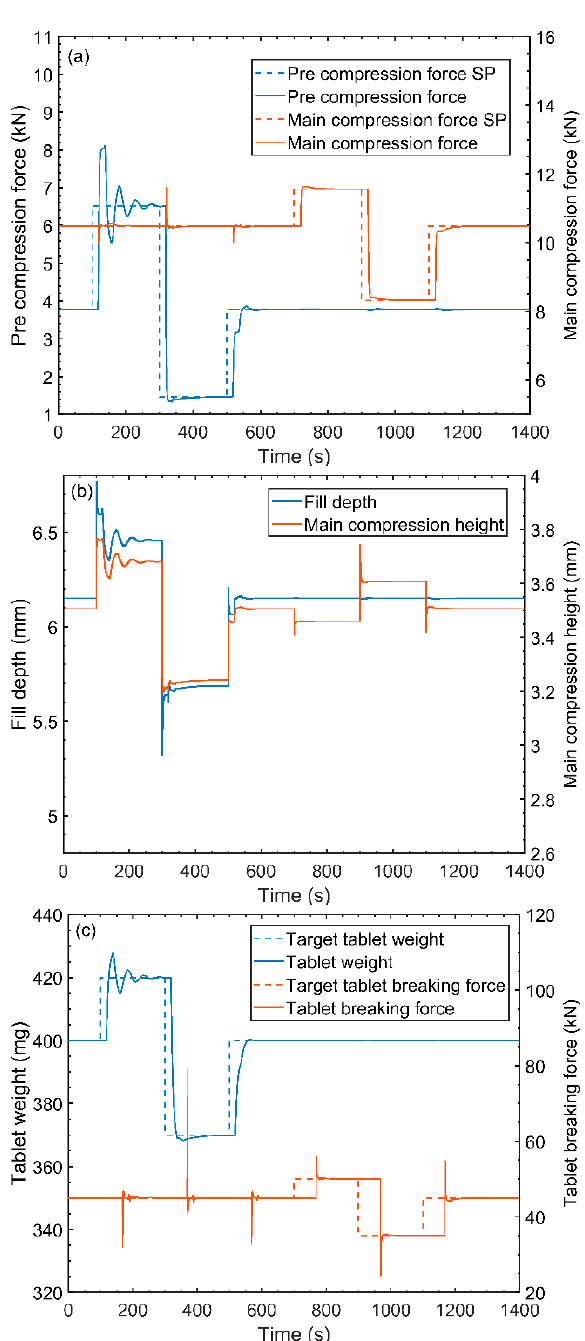
Figure 11. Control strategy 1—Set point tracking scenario. ( a ) Critical process parameters ( b ) Actuators ( c ) Critical quality attributes.